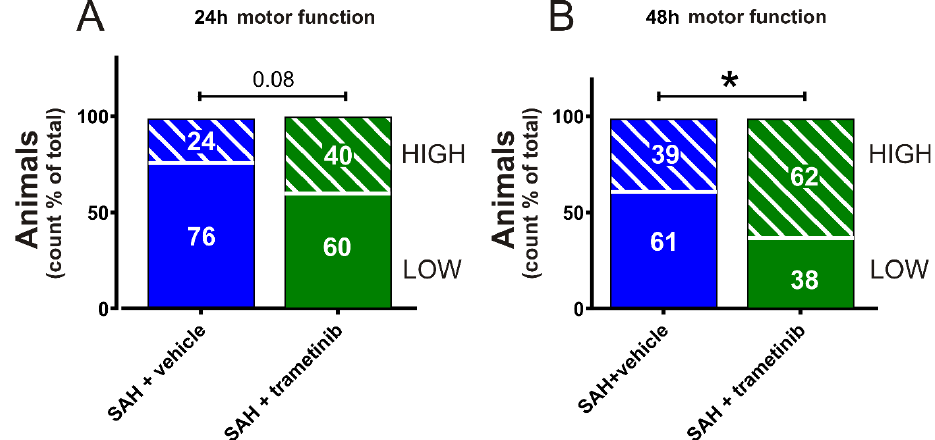
Figure 7. Evaluation of neurologic function post-SAH. Rotating pole test at 10 rpm for: ( A ) 24 h post-SAH and ( B ) 48 h post-SAH. Scored with 4 counts per animal, i.e., 2 scores for left and right rotation, respectively; Low = Unable to traverse in one try; High = Able to traverse in one try. Fisher’s exact test (* p < 0.05) was used for